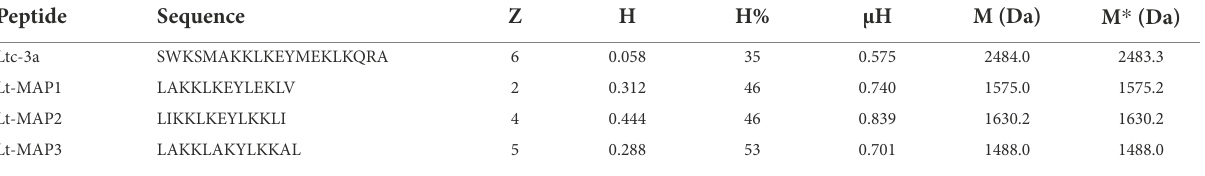
TABLE 1 Sequence of the parental peptide Ltc-3a and the analogs (Lt-MAP1, Lt-MAP2, and Lt-MAP3) with their emphasized physicochemical properties. Peptide